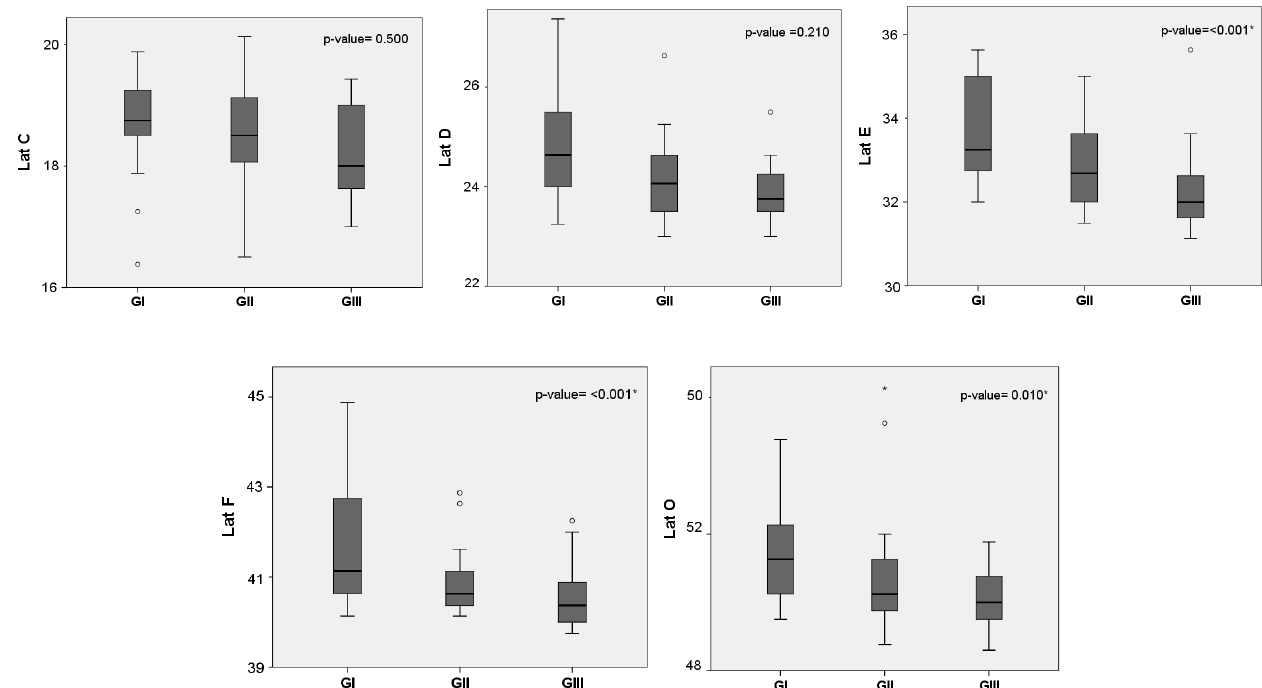
Figure 1. Absolute latency (ms) of the different Frequency Following Response waves in three groups of infants in the first days of life. GI ( n = 38) mean age: 9.5 days; GII ( n = 25) mean age: 23 days; and GIII ( n = 17) mean age: 37 days. Statistical test: Kruskal–Wallis. Lat = latency; * indicates a statistically significant difference. Table 1. Amplitude ( µ V) of the Frequency Following Response waves in the first days of life ( n = 80).